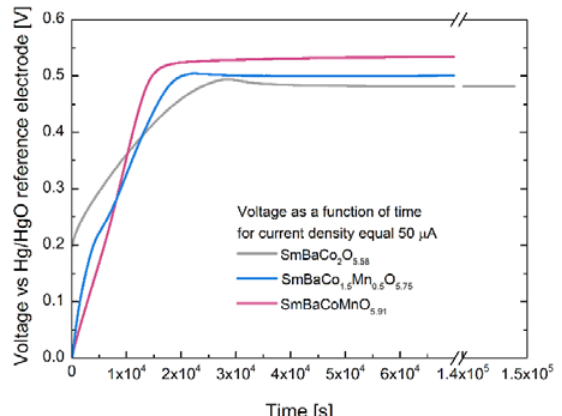
Figure 2. Voltage as a function of time recorded during the galvanostatic polarization (i = 50 μ A) of SmBaCo 2 O 5+ δ , SmBaCo 1.5 Mn 0.5 O 5+ δ , and SmBaCoMnO 5+ δ oxides in the 1 M KOH electrolyte.